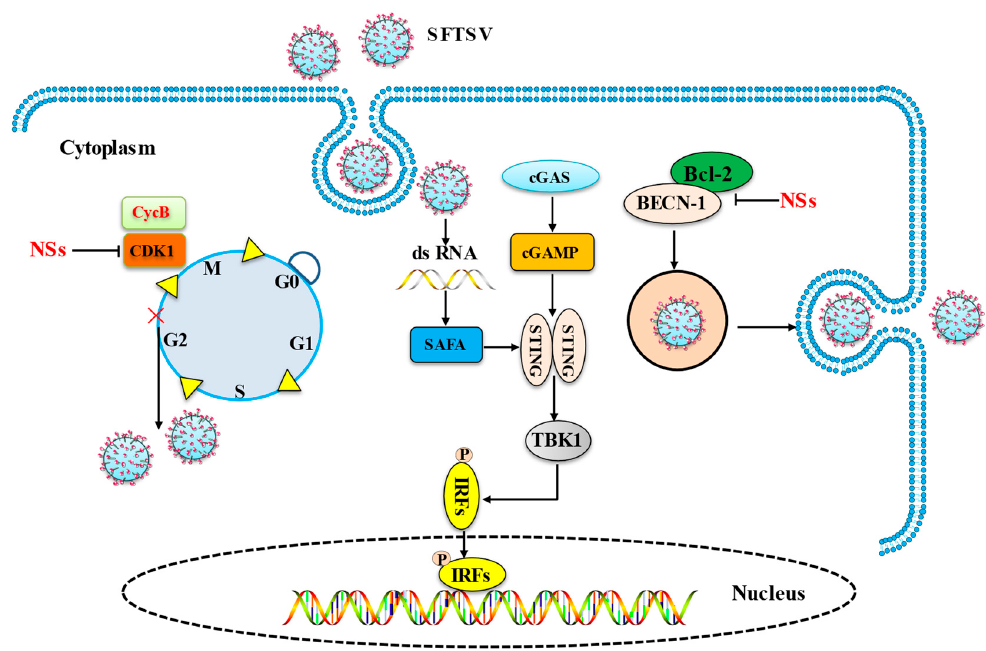
Figure 2. SFTSV mediates cell cycle, apoptosis, and the cGAS-STING pathway to achieve immune escape. The main mechanism by which the SFTSV influences the host cell pathway is depicted in this picture. (1) NSs inhibit host cell cycle protein CDK1 to achieve viral replication. (2) SAFA recruits and promotes activation of the STING–TBK1 signaling axis against SFTSV infection; (3) NSs induce BECN-1-dependent autophagy by breaking the BECN1–BCL2 linkage and complete virus